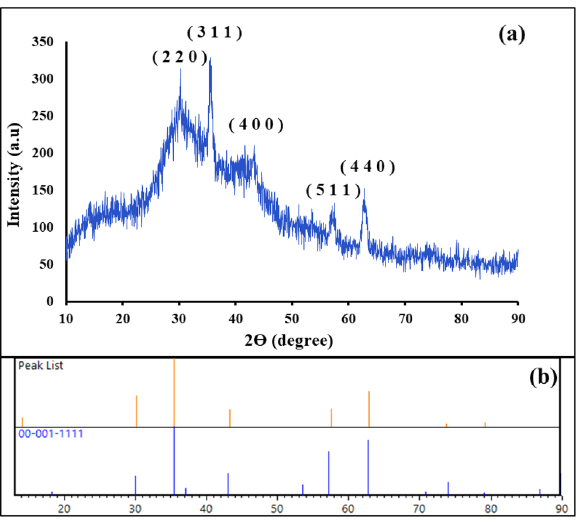
Figure 4. ( a ) XRD pattern of magnetic Fe 3 O 4 @SiO 2 @CPTMS@DA nanocomposite, and ( b ) reference of synthesized